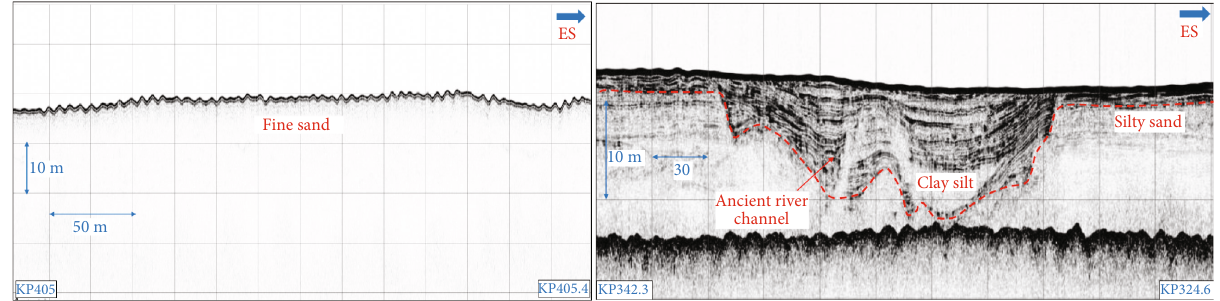
Figure 16: KP165-image data of typical shallow strata on the outer edge of continental shelf (sandy area on the left and ancient river channel area on the